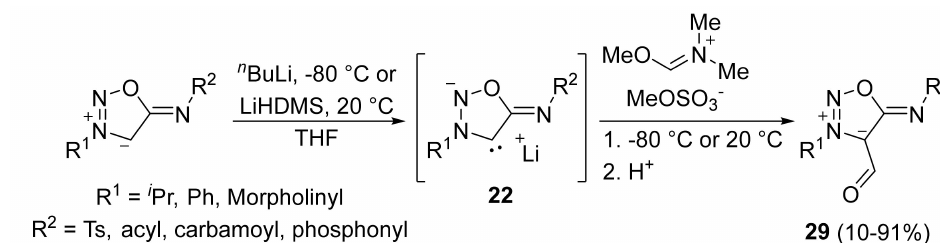
Scheme 18. Formylation of sydnone